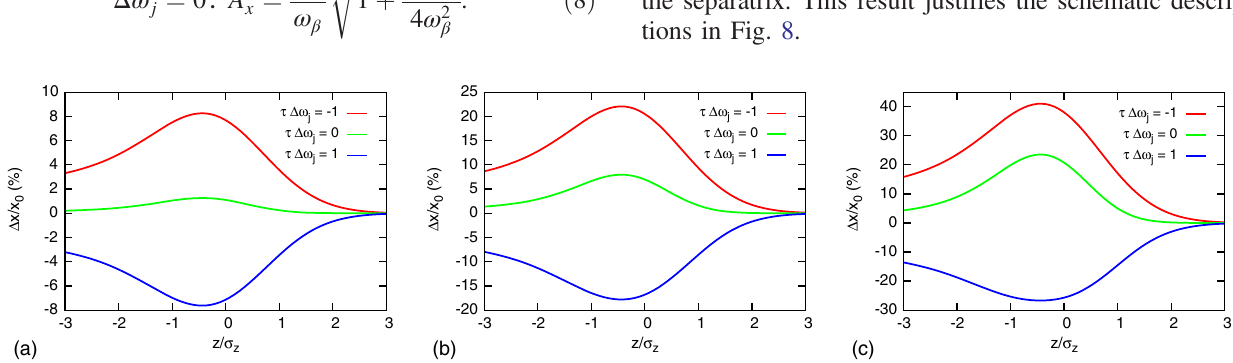
FIG. 9. Theoretical fractional change in oscillation amplitude for various frequency differences at (a) 0.9 mA, (b) 2.3 mA, and (c) 4.1 mA. Within this model nearly all the particles should be between the blue and red lines at Δ ω j ¼ (cid:3) 1 = τ